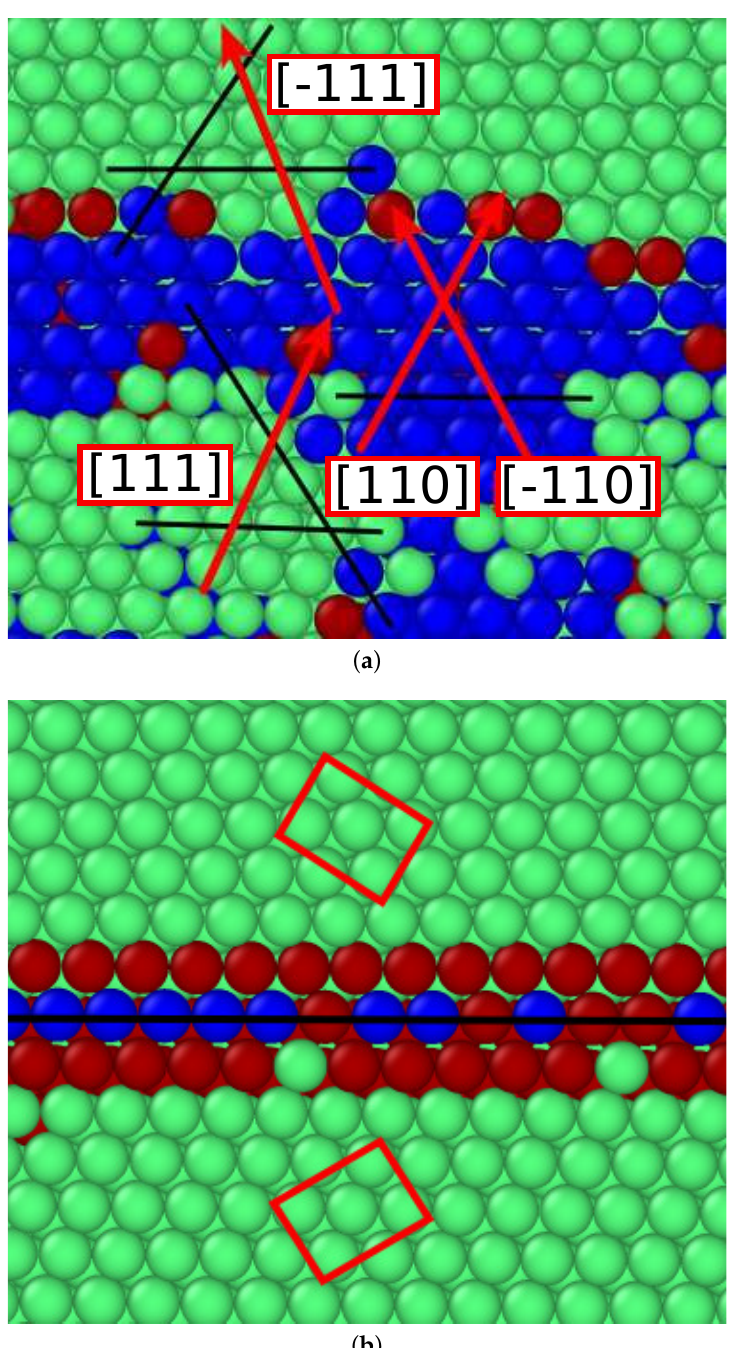
Figure 9. View on the transforming system at a temperature of: ( a ) 208 K, corresponding to Figure 8d; and ( b ) 4 K, corresponding to Figure 8e. The view direction is perpendicular on a ( 110 ) bcc (cid:107) ( 111 ) fcc plane. Red arrows mark the conserved directions, [ 110 ] fcc (cid:107) [ 111 ] bcc and [ ¯110 ] fcc (cid:107) [ 111 ] bcc . After finishing the transformation, a twin boundary has been formed; red rectangles mark the twin structure in ( b